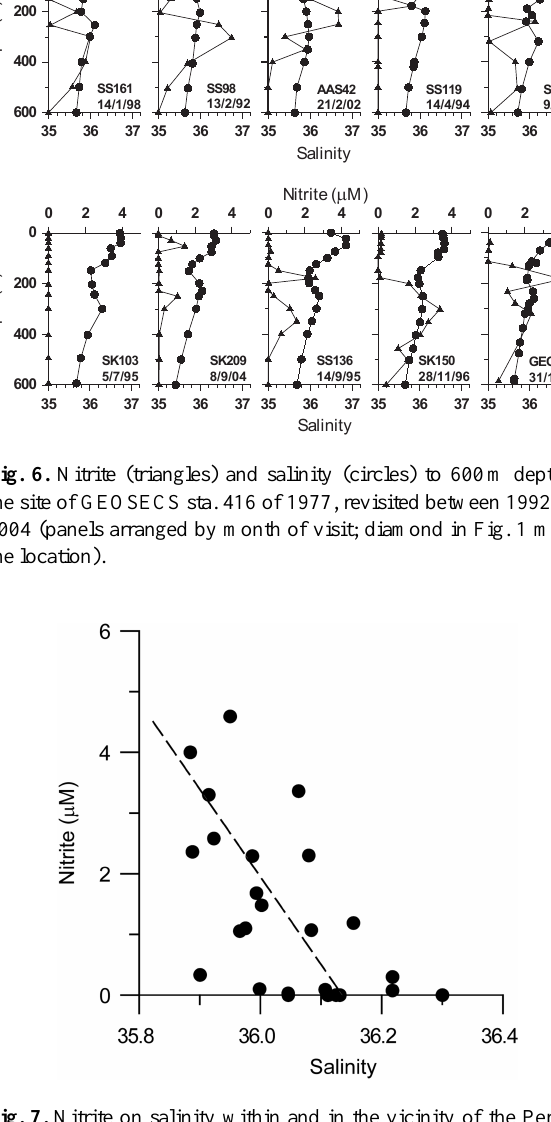
Fig. 7. Nitrite on salinity within and in the vicinity of the Persian Gulf salinity maximum ( σ t range, 26.18–26.74kgm − 3 ) during the visits to the GEOSECS site shown in Fig. 6. The equation for the = − 14.566 × salinity+526.30. regression line is NO − 2